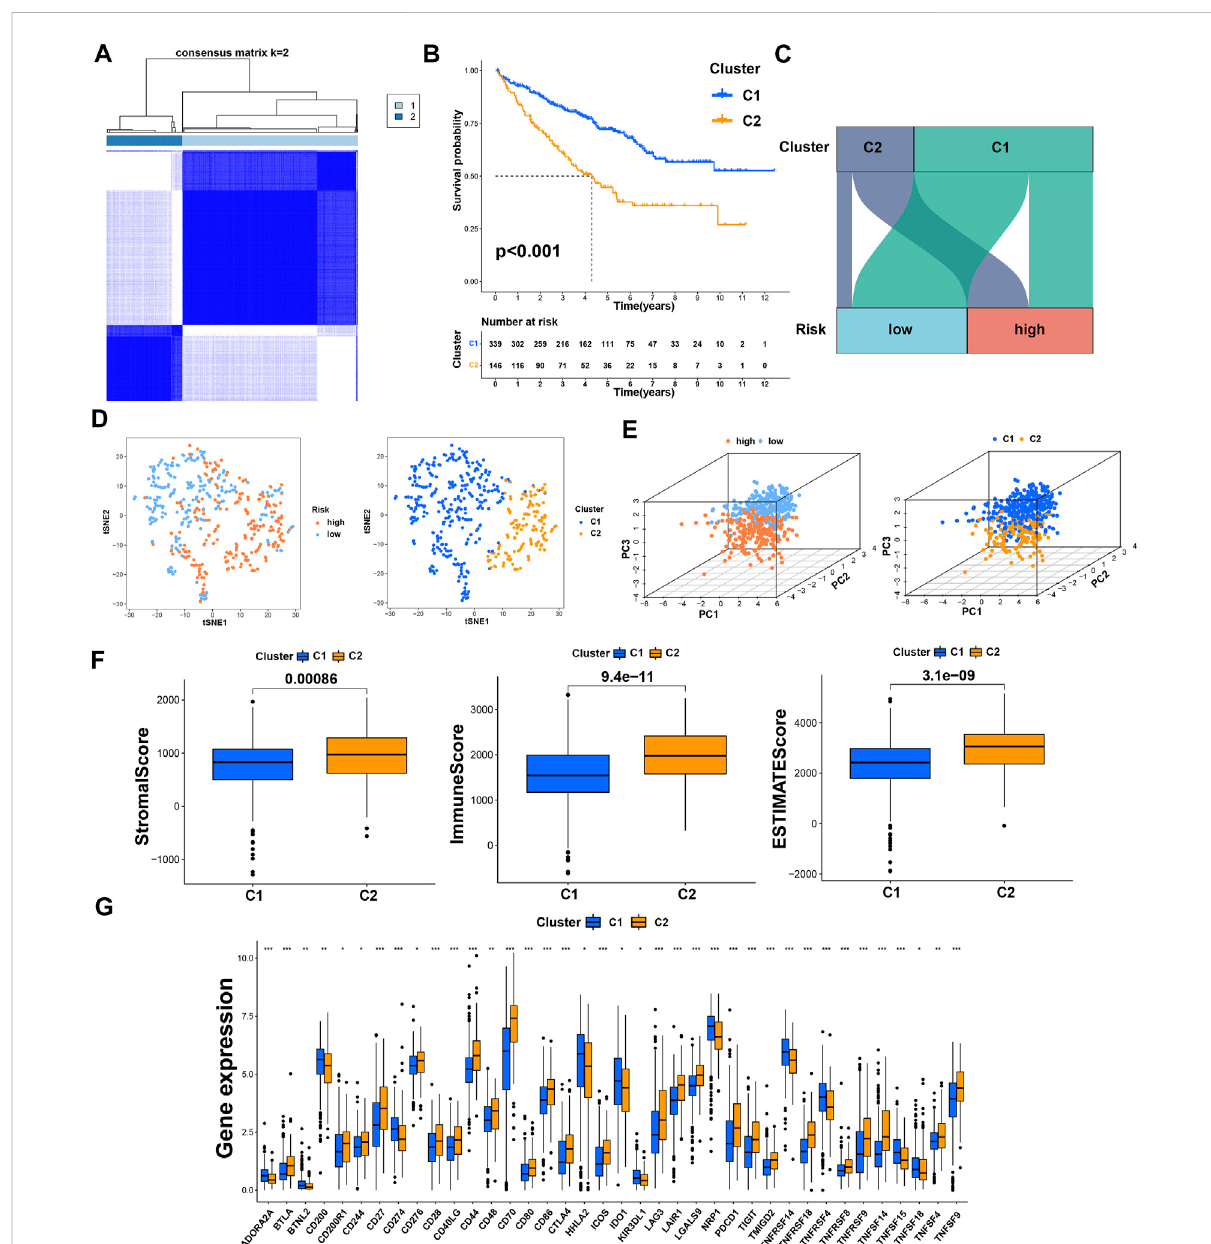
FIGURE 8 Distinctionbetweenriskgroupsandclusters. (A) Patientsweredividedintotwoclustersaccordingtotumorsubtypes; (B) Kaplan – Meiersurvival curvesofOSinclusters; (C) theSankeydiagramofriskgroupsandclusters; (D) thet-SNEofriskgroupsandclusters; (E) the3DPCAofriskgroupsand clusters; (F) the comparison of the stromal score, immune score, and estimate score between clusters; (G) the difference of checkpoints expression between clusters. * means p < 0.05; ** means p < 0.01; *** means p <